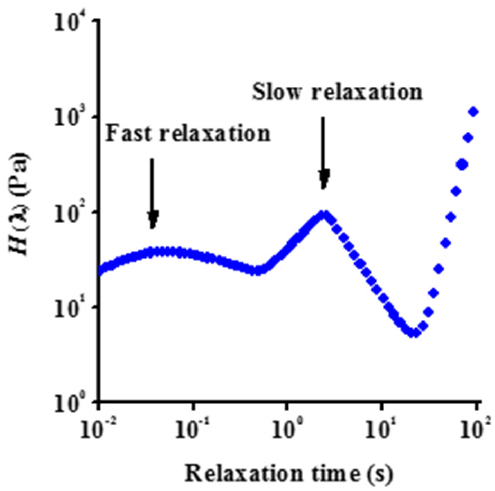
Figure 7. Relaxation time spectrum of a fresh aqueous suspension.